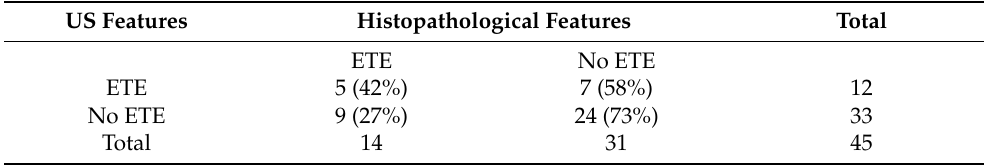
Table 3. Extrathyroidal extension according to US and histopathological reports.